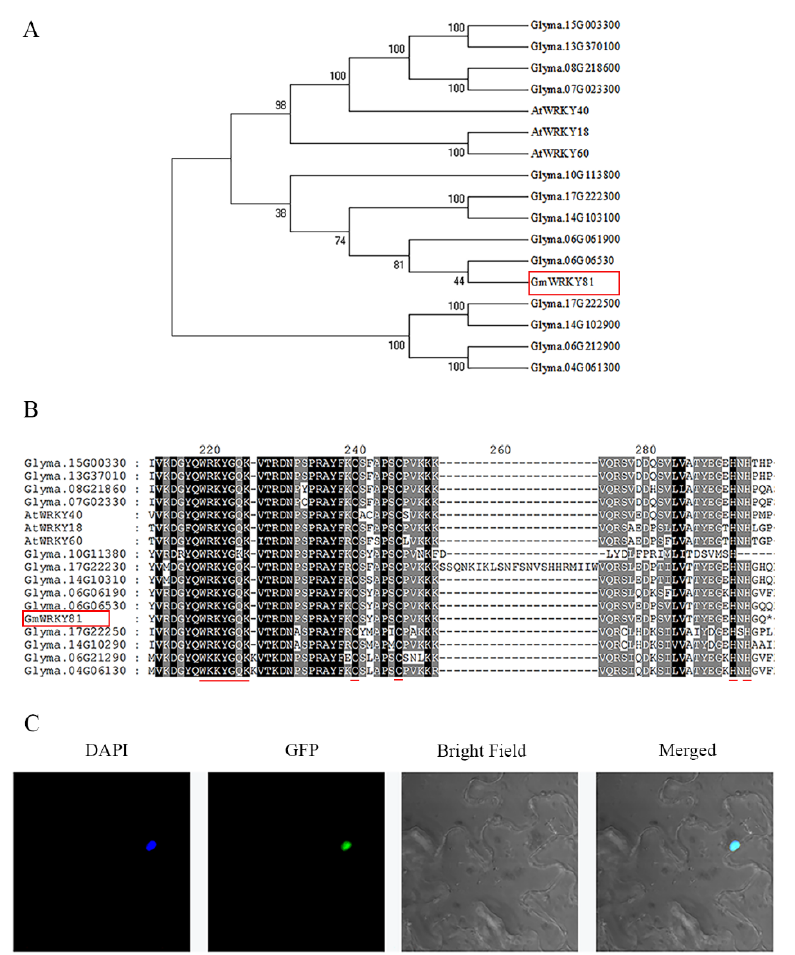
Figure 2. Homology analysis and subcellular localization of GmWRKY81. ( A ) Phylogenetic tree analysis of proteins from II a subfamily of WRKY family in soybean and Arabidopsis thaliana . ( B ) Multiple amino acid sequence alignment of proteins from II a subfamily of WRKY family in soybean and Arabidopsis thaliana . The GmWRKY81 protein is marked with a red rectangle, and the red underline marks the WRKYGQK motif and C 2 H 2 zinc finger structure. ( C ) The subcellular localization of GmWRKY81 in epidermal cells of tobacco ( N. benthamiana ). DAPI: 4 (cid:48) ,6-diamidino-2-phenylindole, a nucleus-specific fluorescence dye. GFP: green fluorescence protein. Merged: the overlapped image of DAPI, GFP and bright